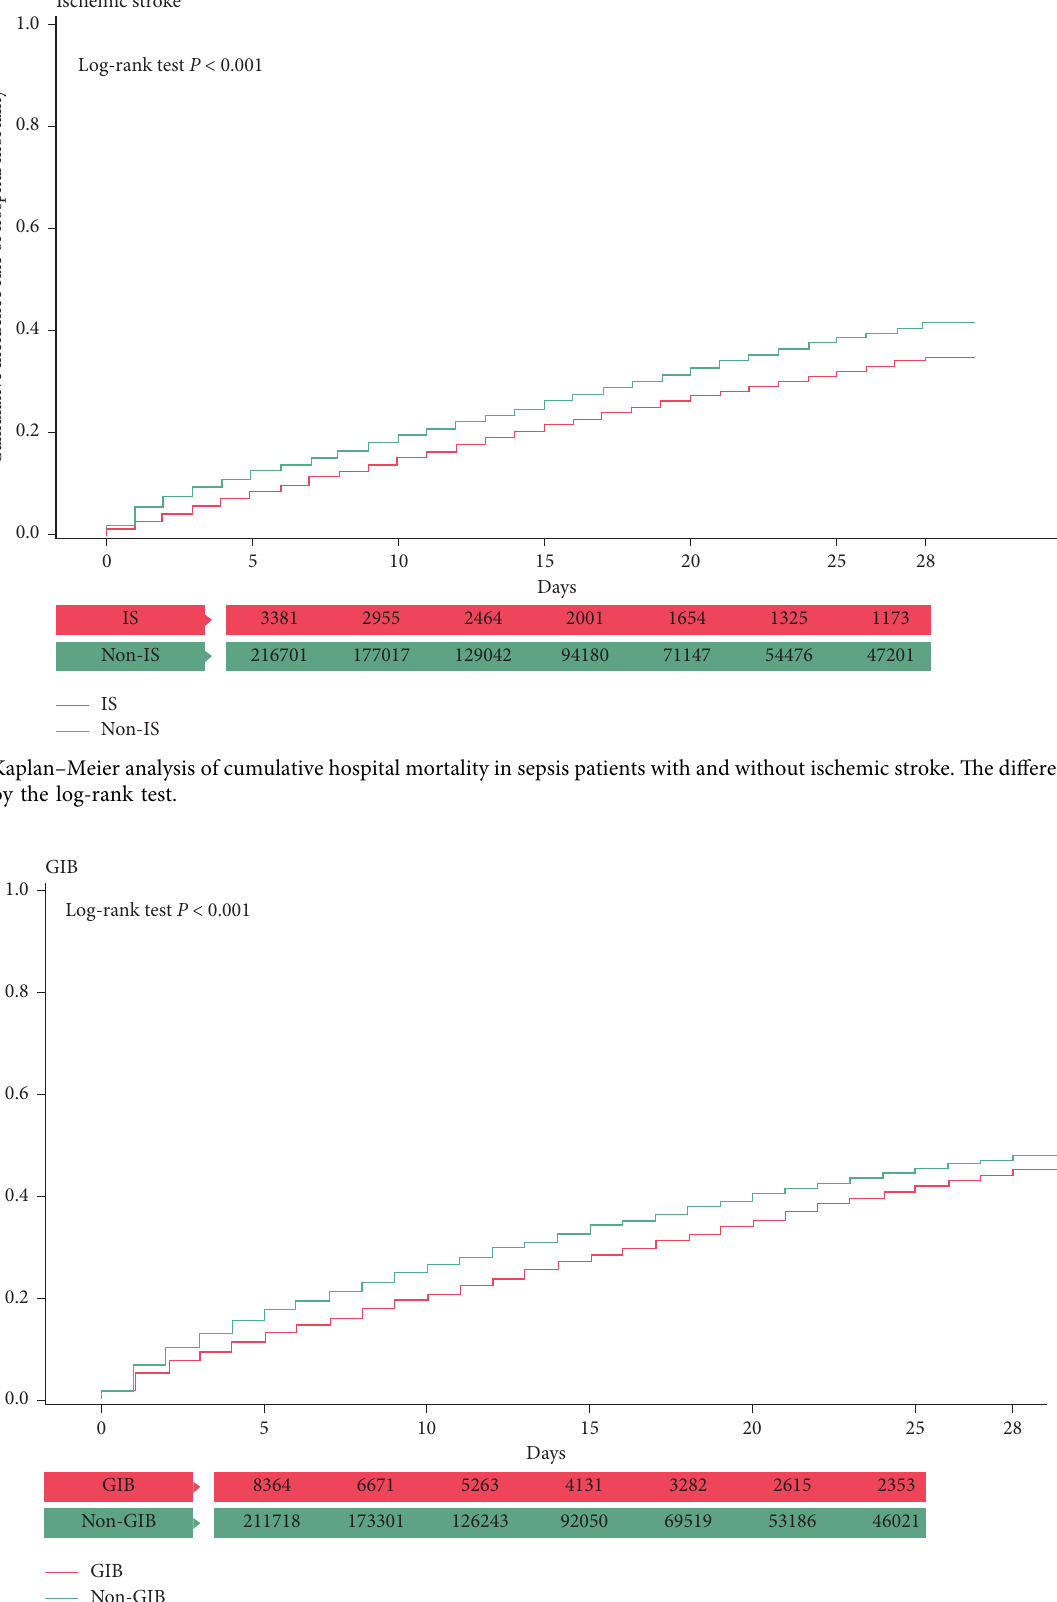
Figure 4: Kaplan–Meier analysis of cumulative hospital mortality in sepsis patients with and without GIB. The differences were evaluated by the log-rank test.